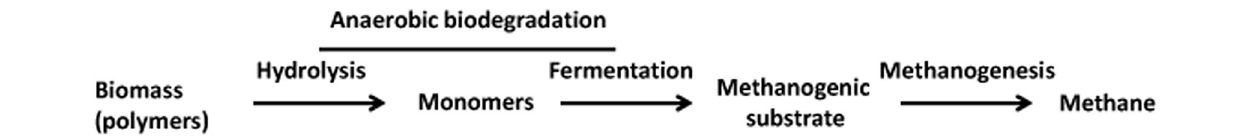
FIGURE 1 | Methanogenic degradation of biomass—an overview. Examples: Polymers—cellulose, hemicellulose, and proteins; Monomers: glucose, xylose, and amino acids. Methanogenic substrates: hydrogen plus carbon dioxide, formate, acetate, and